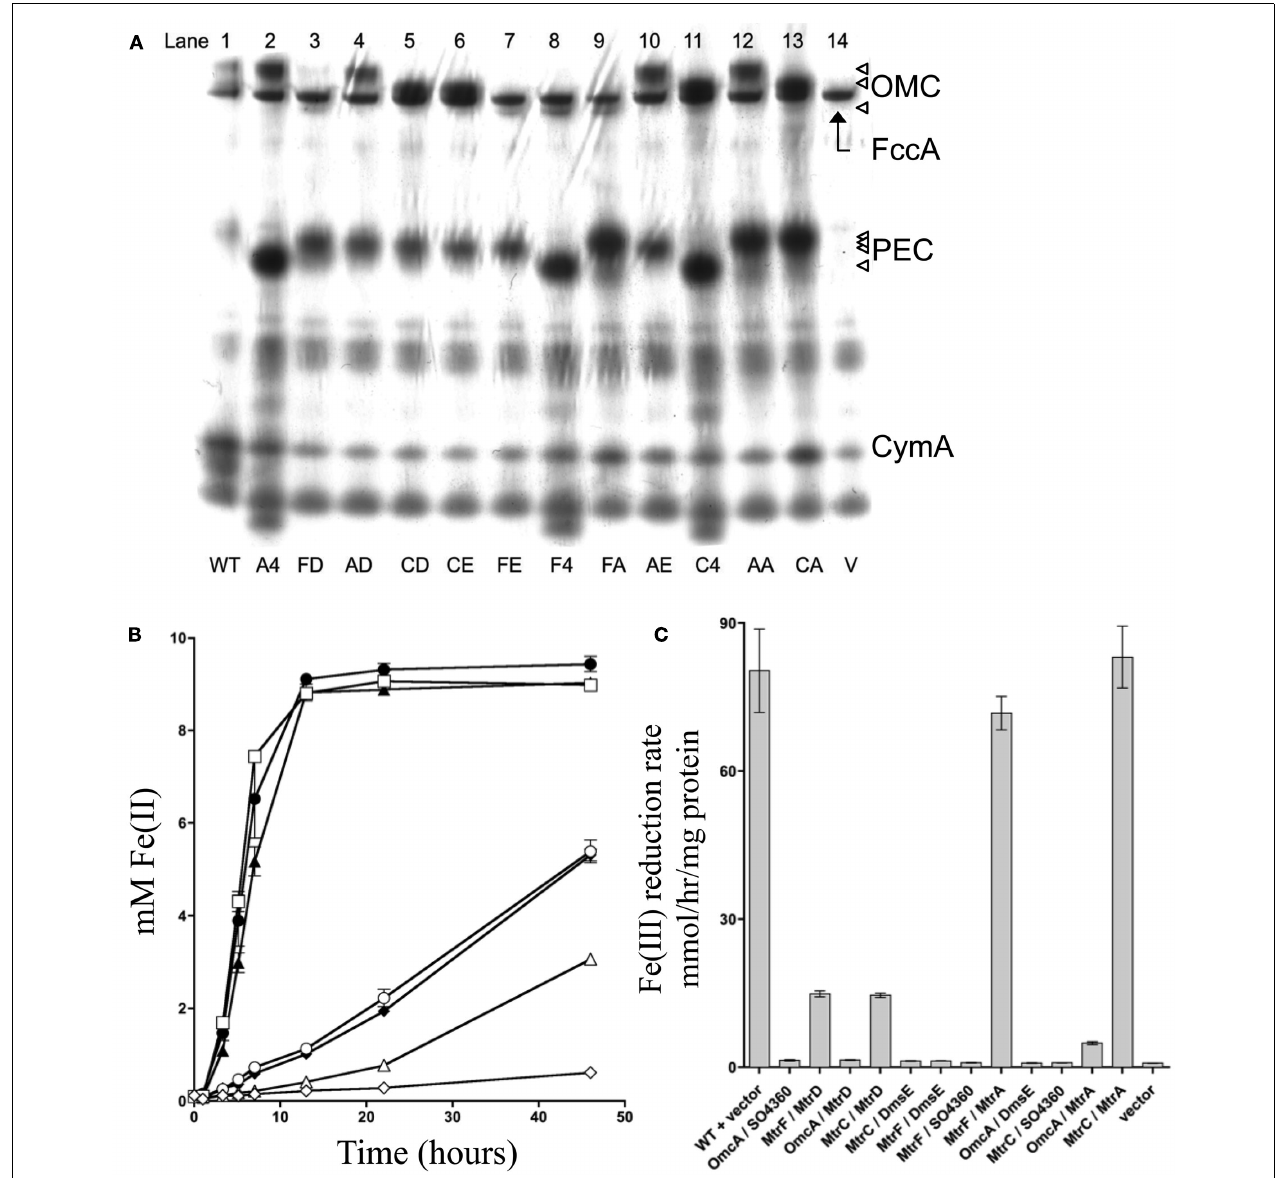
OmcA/MtrA (lane 12), MtrC/MtrA (lane 13), and empty pBBR-BB (lane 14). (B) Ferric citrate reduction for Δ Mtr strains complemented with vectors encoding mtrF/mtrD ( (cid:5) ), mtrC/mtrD ( (cid:3) ), mtrF/mtrA ( (cid:6) ), omcA/mtrA ( (cid:2) ), mtrC/mtrA • ( (cid:2) ), and empty pBBR-BB ( ♦ ). MR-1 with empty pBBR-BB ( ) is included for reference. All not shown PEC/OMC combinations did not reduce ferric citrate significantly faster than the Δ Mtr + empty vector control and for the sake of brevity are not depicted. (C) Rates of Fe(III) citrate reduction for Δ Mtr strain complemented with the indicated proteins. Rates are reported in millimolar per hour per microgram